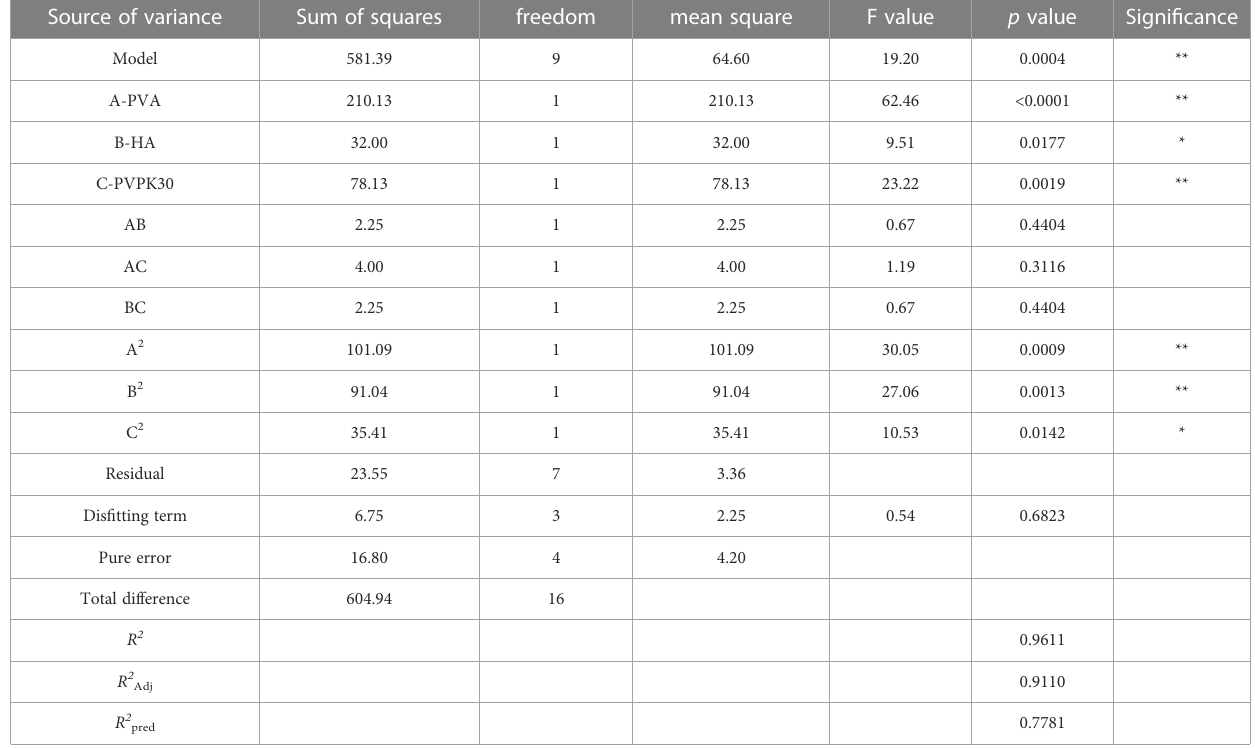
TABLE 3 Analysis of variance of regression model.